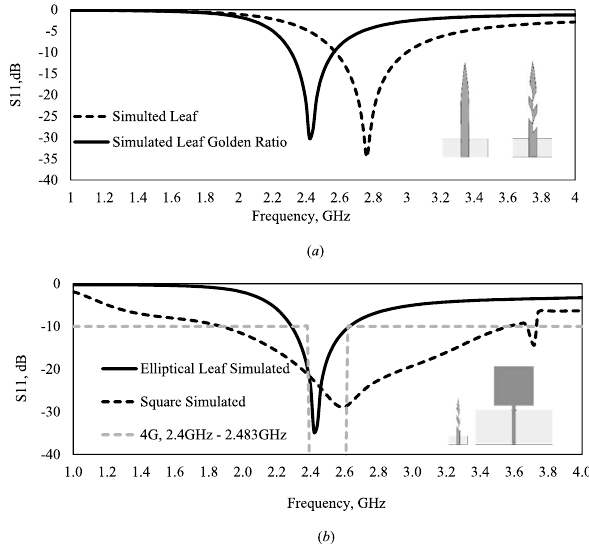
Figure 2. Comparison of simulated square shape and elliptical leaf directional monopole antennas performed in Ansys 2016: ( a ) Elliptical leaf, and elliptical leaf with aperture by the golden ration without the reflector; ( b ) square shape and elliptical leaf with aperture by the golden ratio with reflector.